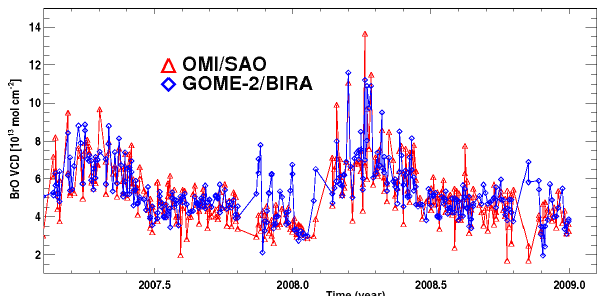
Figure 5. Time series comparison of SAO OMI (red) BrO and BIRA/GOME-2 (blue) BrO VCDs from February 2007 to Novem- ber 2008 using simultaneous nadir overpasses occurring at high lat- itudes, around 75 ◦ S and 75 ◦ N, and within 2min between OMI and GOME-2 observations.